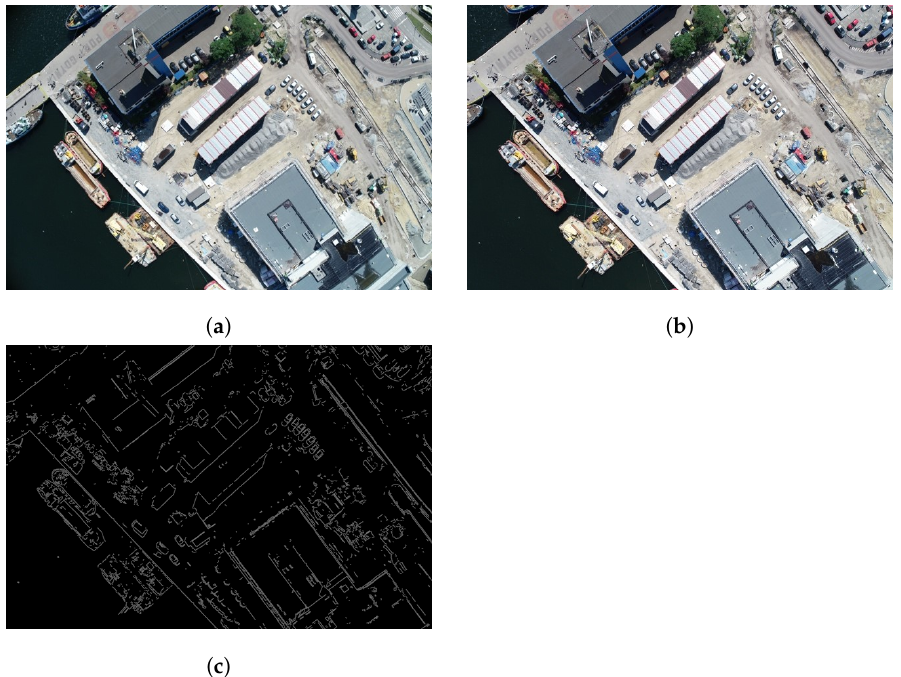
Figure 1. The view of the pier: ( a ) original, ( b ) after removing geometric distortions, ( c ) after edge